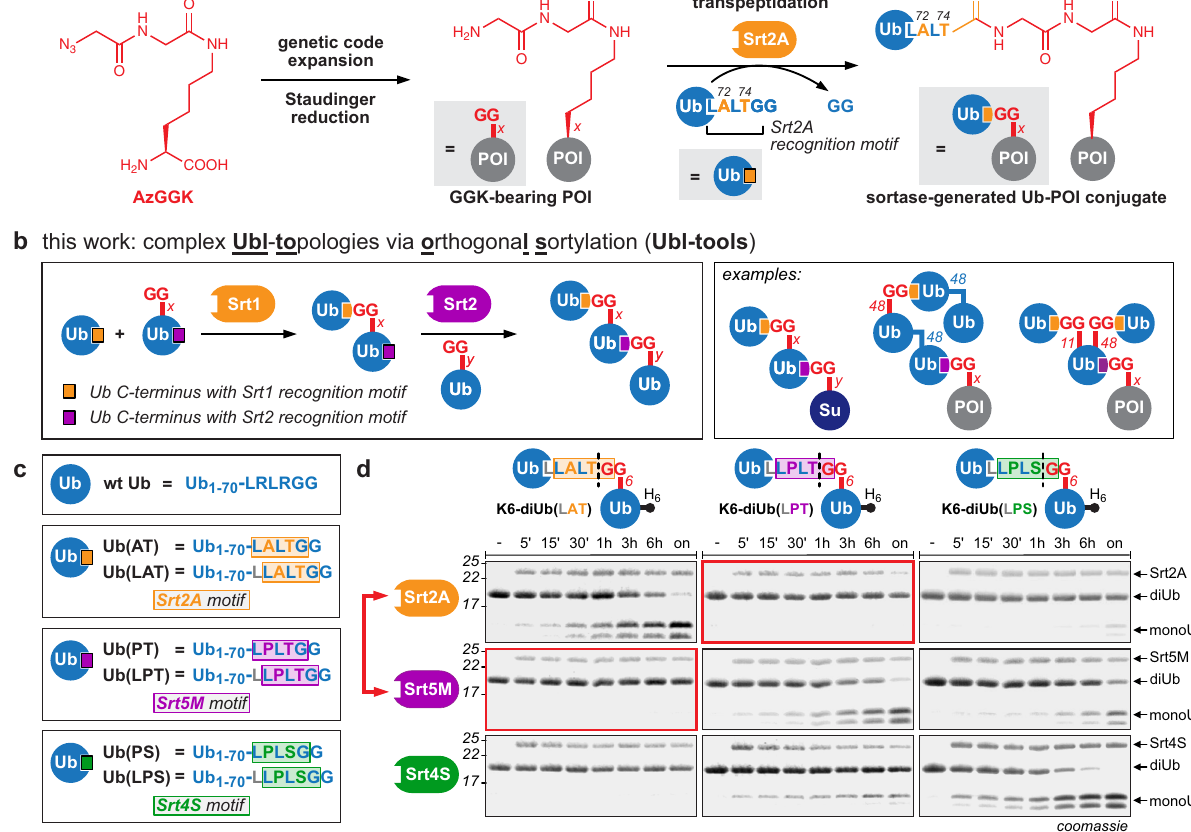
Fig. 1 Access to de fi ned Ub/Ubl topologies via orthogonal sortylation (Ubl-tools). a Sortylation allows site-speci fi c monoubiquitylation of a protein of interest (POI) and relies on site-speci fi c incorporation of AzGGK, Staudinger reduction to access GGK-modi fi ed proteins and sortase-mediated transpeptidation. The resulting Ub-POI conjugates display a native isopeptide bond and two point mutations in the Ub C-terminus (R72A and R74T). b Ubl- tools expands sortylation to complex Ub/Ubl topologies by implementing a pair of orthogonal sortases that enables iterative